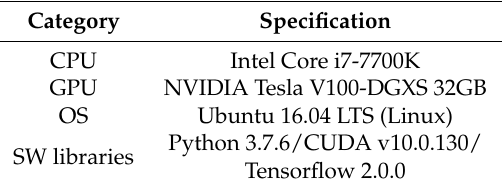
Table 2. Runtime environment